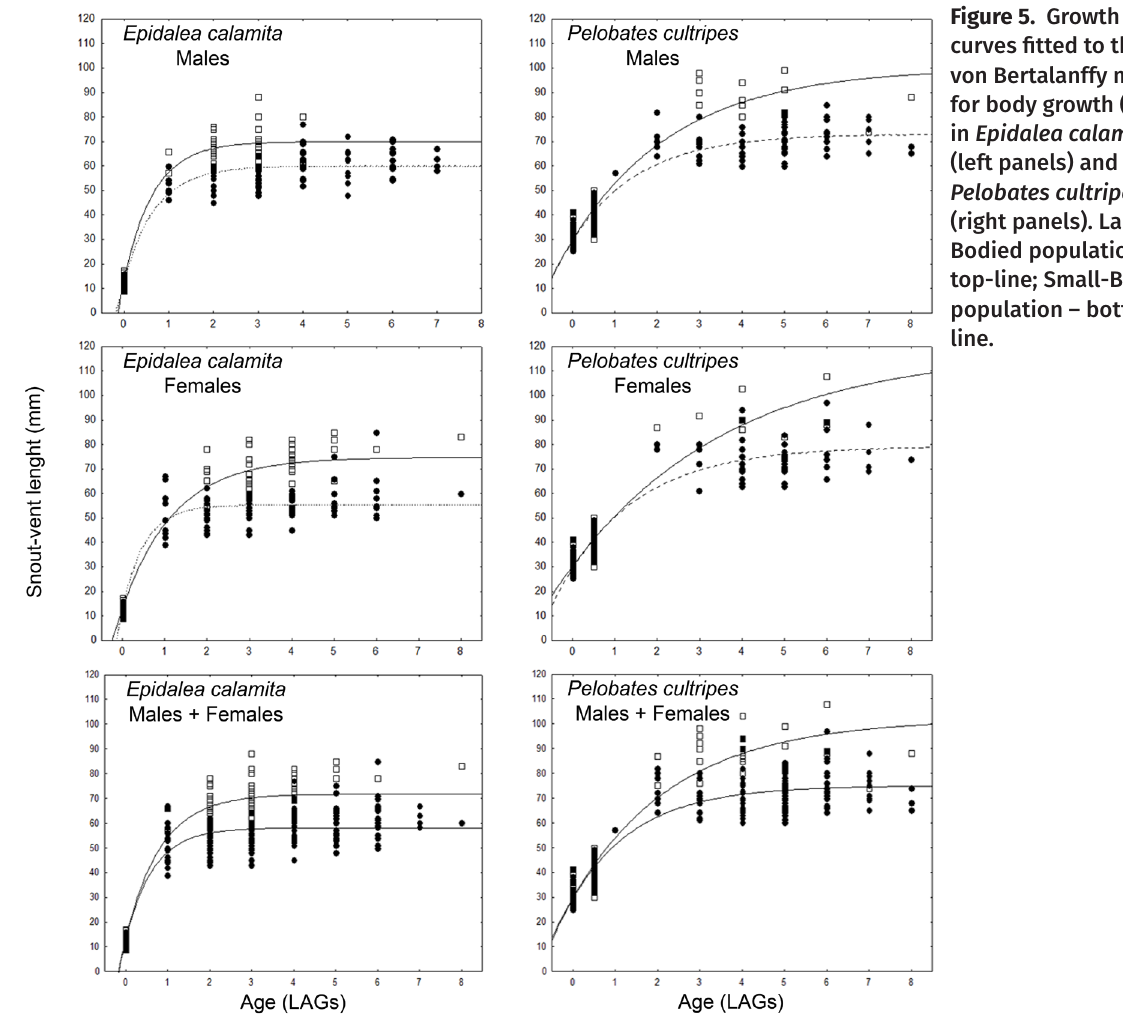
Figure 5. Growth curves fitted to